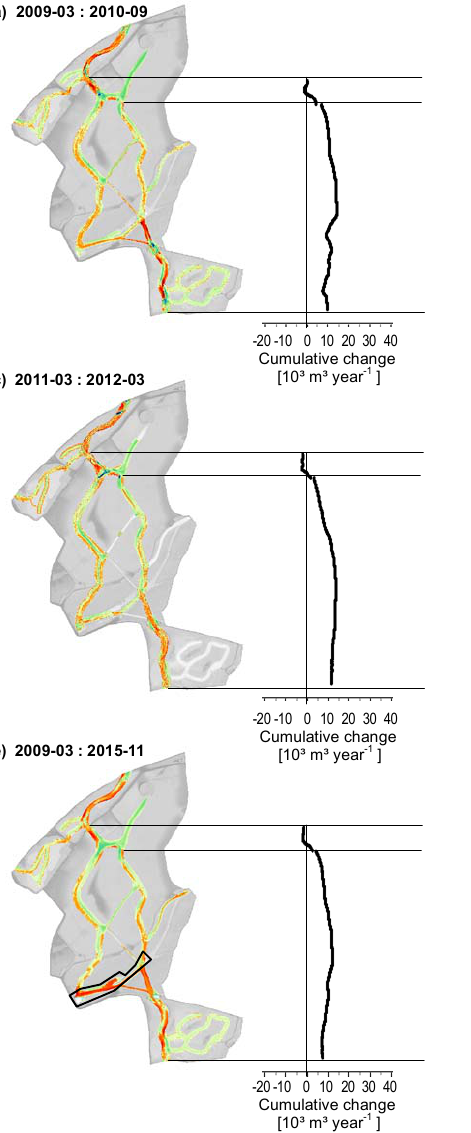
Figure 3. The difference in channel bed level and the cumulative channel bed volume for each monitoring period. The cumulative channel bed volume is shown along a N–S transect starting from the Spiering polders (purple in Fig. 1). The budget of the Wassende Maan (blue in Fig. 1) is added at the second black line. The channel in the southwest of the study area was dredged in the monitoring period 2012–2015. The dredged area is excluded in the analysis and not shown in the cumulative channel bed